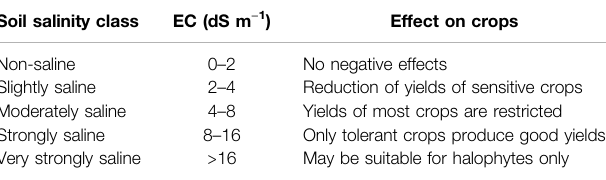
TABLE 2 | Soil salinity classes and effects on crop